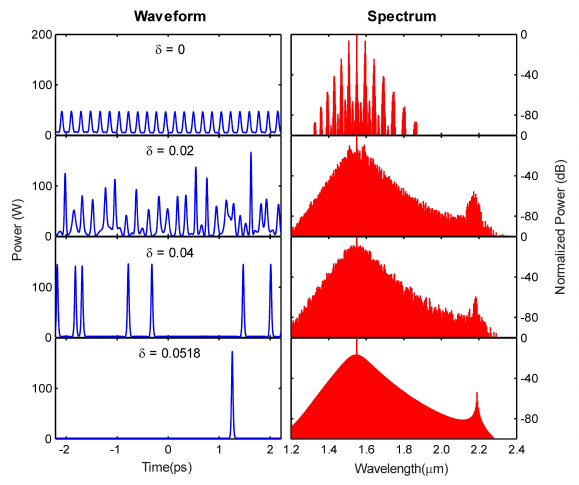
Figure 18: The waveforms and spectra of the Kerr comb generated in an Si 3 N 4 microresonator with a quality factor Q = 5 × 10 5 . The round trip time t R = 4.425 ps. P in = 1.5 W, αL = 0.012 , θ = 0.0025 , 𝛾 = 1 W −1 /m and β 2 = −61 ps 2 /km. The phase detuning δ increases from 0 to 0.0518 from top to